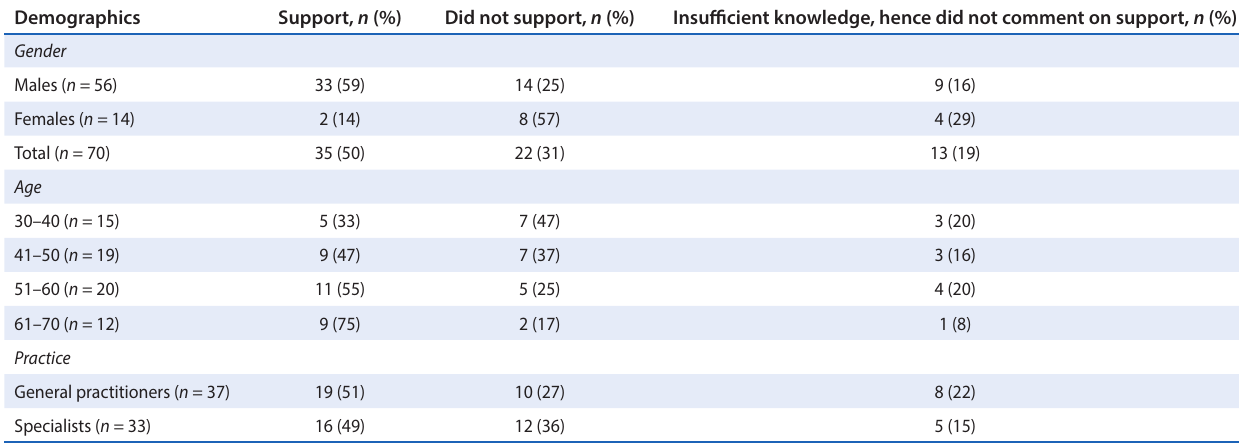
Table 3: Respondents’ support for the NHI according to gender, age and practice ( n = 70)